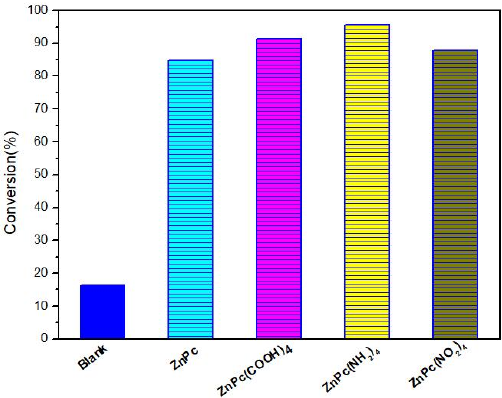
Figure 7. The influence of conjugate effect of phthalocyanine